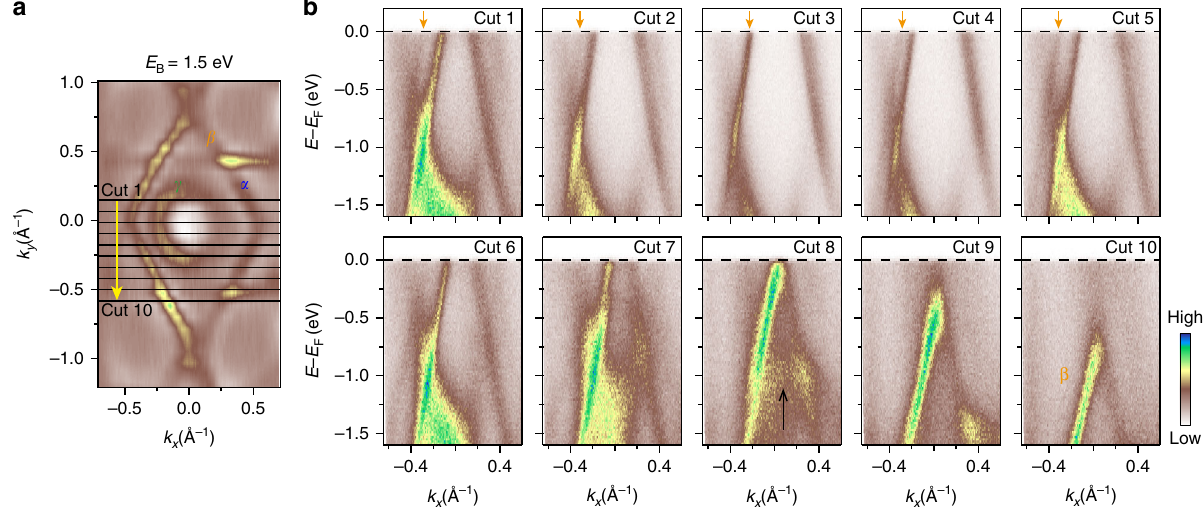
Fig. 4 Detailed band structures of Cu 2 Si on Cu(111). a Constant energy contour taken at E B = 1.5 eV. The black lines (cut 1 to cut 10) indicate the positions where the ARPES intensity plots in b are taken. b ARPES intensity plots measured along cut 1 to cut 10. The orange arrows indicate the evolution of band β . The black arrow in cut 8 indicates a fl at band that originates from NL1. All the data were taken with p -polarized